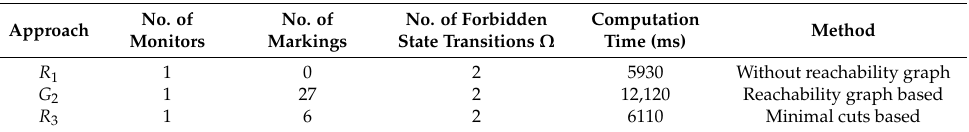
Table 15. Comparison results of case study